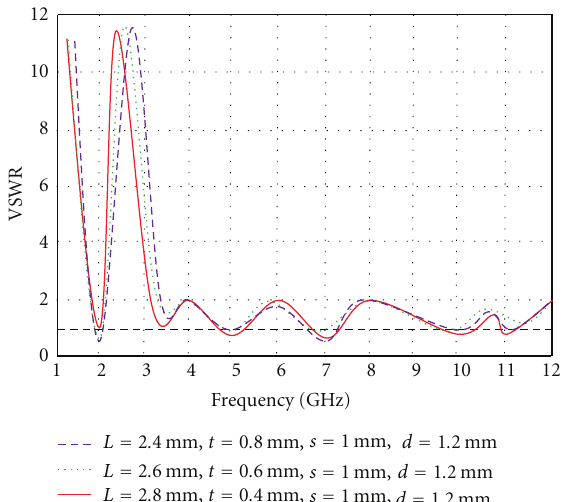
Figure 6: Simulated and Measured